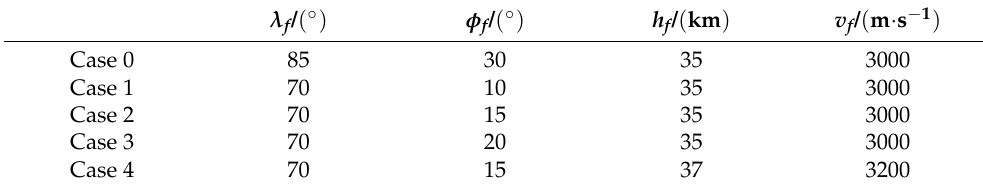
Table 4. Terminal condition configuration for five